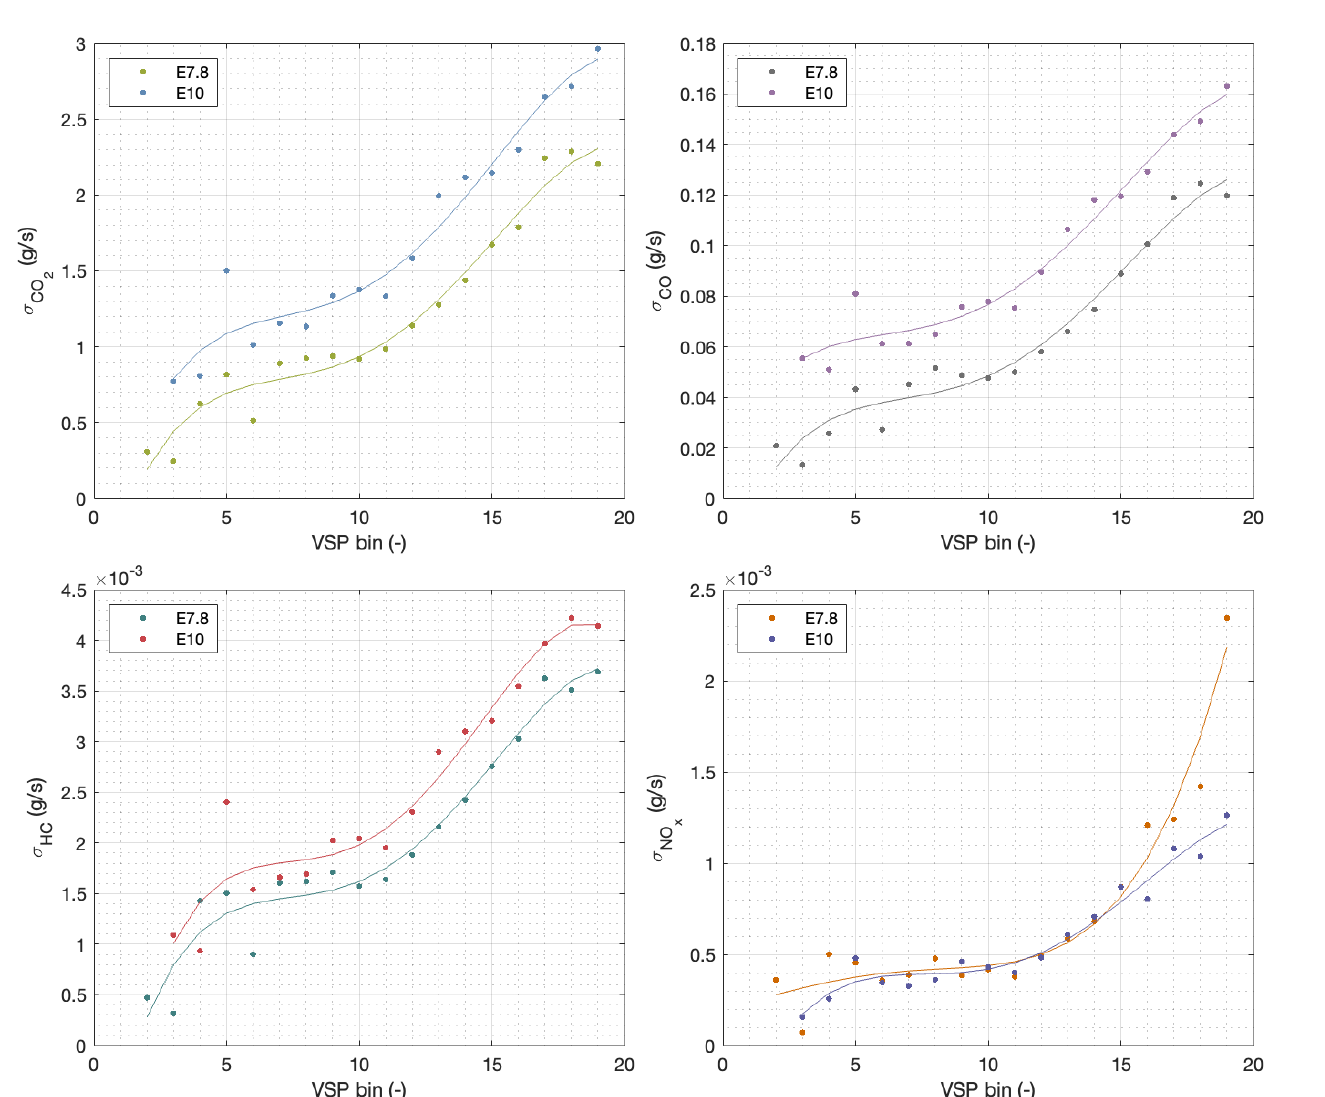
Figure 15. Difference in standard deviation between E7.8 and E10 for emissions